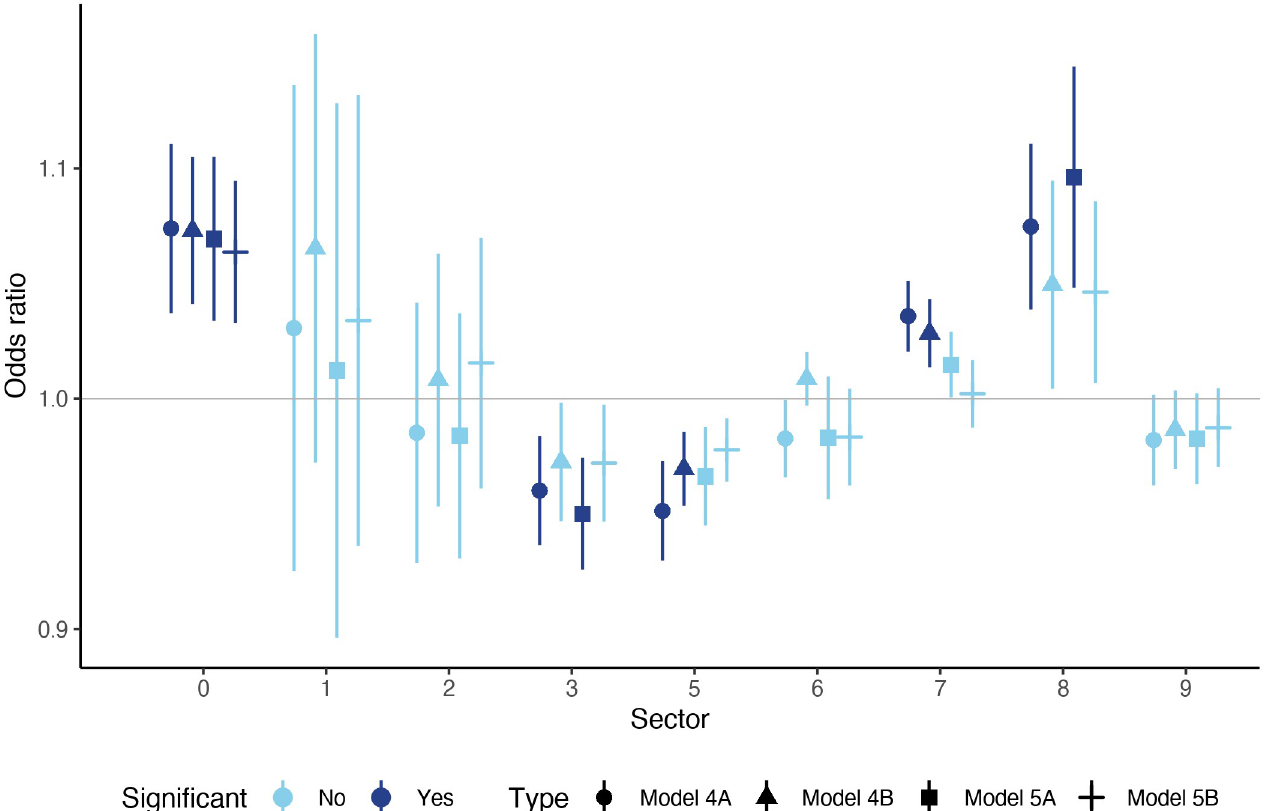
Fig 6. Results of Model 4A, 4B, 5A and 5B for the upstream variables. Every marker/line represents the estimated odds-ratio of a given sector in a given model type, measured on the vertical axis. The shape of the markers shows the model type. Circles represent estimated odds-ratios in Model 4A, where every sector is included simultaneously, plus the control variables. Triangle markers indicate the estimated odds-ratios in Model 4B, where sectors enter one-by-one. Squares show the estimated odds-ratios in Model 5A, where sectors enter simultaneously together with downstream connections (all sectors). Horizontal line markers show the estimated odds-ratios in Model 5B, where sectors enter individually, together with their downstream counterparts. Dark blue markers/lines show significant odds-ratios at the 10% level, light blue markers/colors represent non-significant results. The length of the vertical lines refer to the robust standard errors around the point-estimates. Sectors are grouped along the horizontal axis, marked by their codes (see Table 1 for reference).